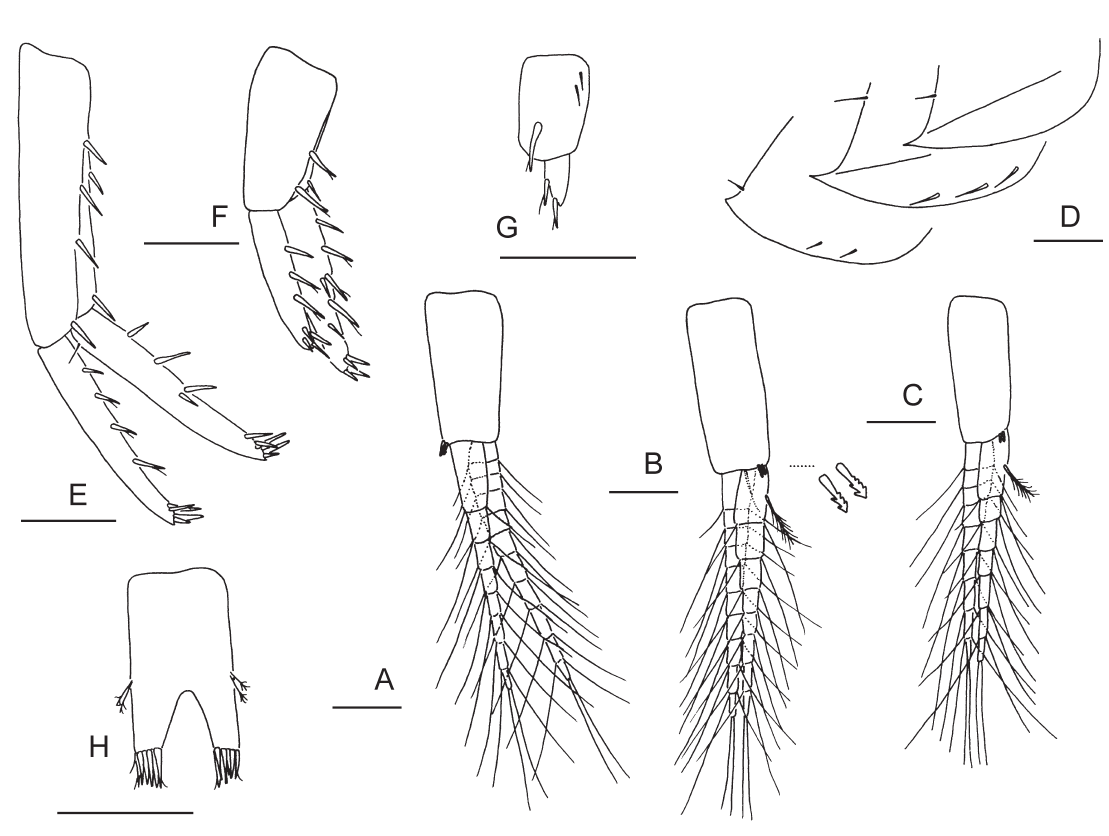
Fig. 6A-H. Synurella ambulans (F. Müller, 1846), ♂, 4.5 mm, FENU X34906/Cr-1406, MO. A . Pleopod 1. B . Pleopod 2. C . Pleopod 3. D . Epimera 1-3. E . Uropod 1. F . Uropod 2. G . Uropod 3. H . Telson. Scale bars 0.2